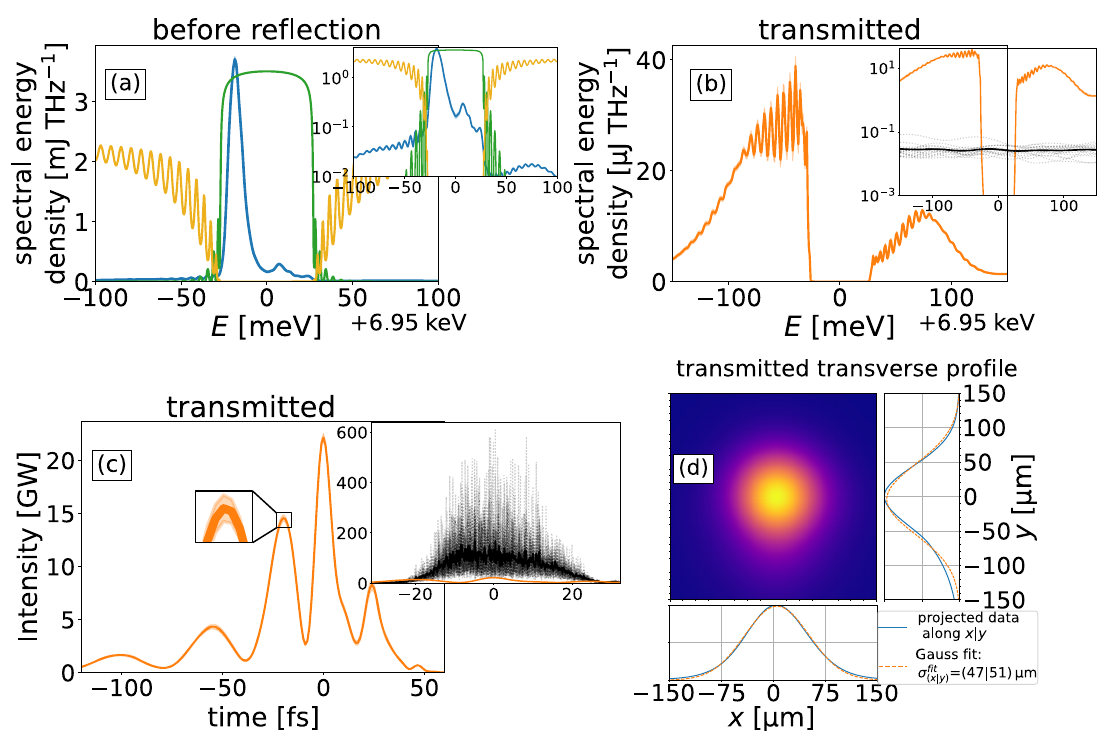
FIG. 4. (a) shows the transversely integrated longitudinal spectra of the x-ray pulse at E c ¼ 6 . 95 keV directly after the undulator (blue). (a) also shows the cumulative reflection (green) of both diamond mirrors and the transmissivity (yellow) of the downstream one. The inset is the same graph with logarithmic ordinate to better highlight the pulse tail outside the reflection bandwidth. (b) displays the transversely integrated longitudinal spectra of the transmitted pulse (orange). In the inset also the SASE spectra of 15 statistical runs in light gray and their ensemble average in black are plotted on a logarithmic scale for comparison. (c) shows the transversely integrated intensity profile in the time domain, where the orange curve is the average over 100 round trips in saturation and 15 consecutive runs. The width of the line corresponds to the respective rms range. As the relative variation is very small, for better visualization, the inset in (c) on the left zooms in such a widening. The same rms widening is existent in (a) and (b) but likewise very small. The inset in (c) on the right displays the comparison to 15 SASE runs. (d) presents the transverse projection of the transmitted pulse, which is on the same scale as the one trapped in the cavity, but less affected by wavefront